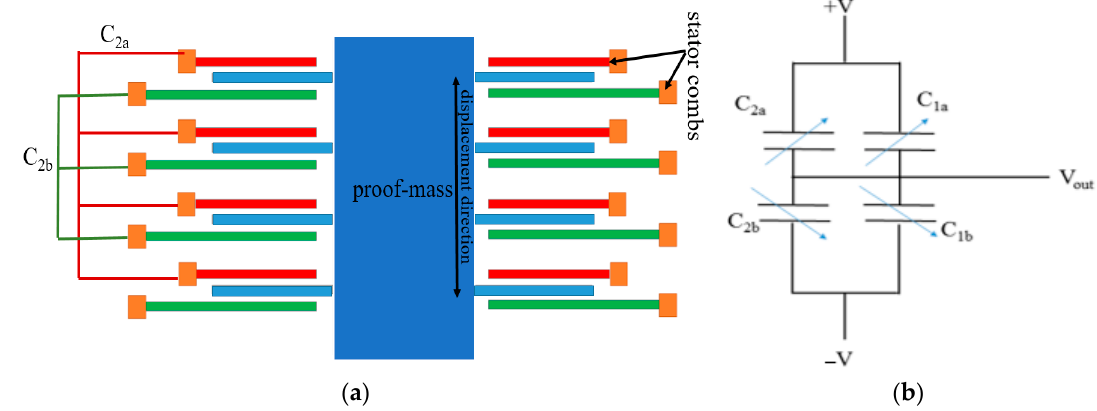
Figure 4. Sensing scheme of ( a ) gap changeable fully differential accelerometer ( b ) equivalent circuit.